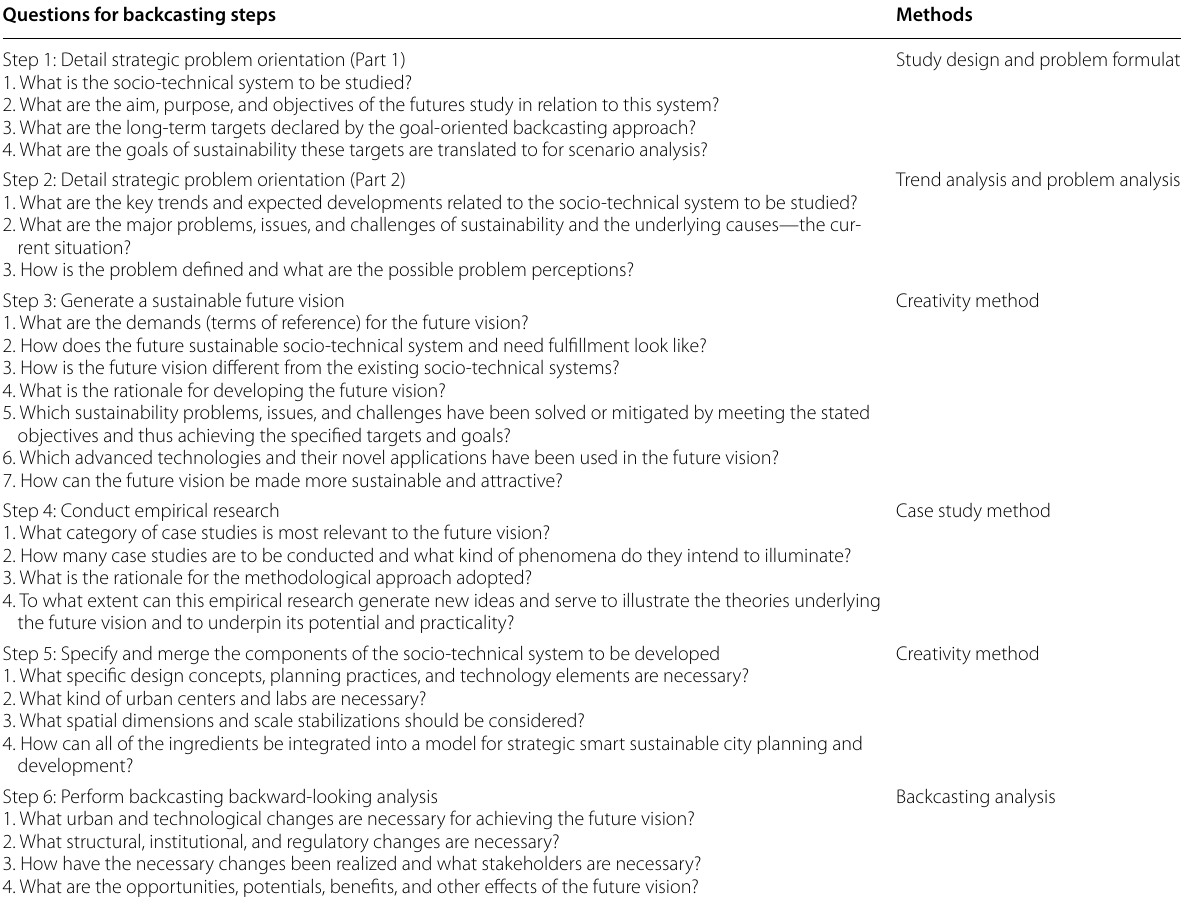
Table 1 The guiding questions for each step in the backcasting study Source: Bibri (2019b) Questions for backcasting